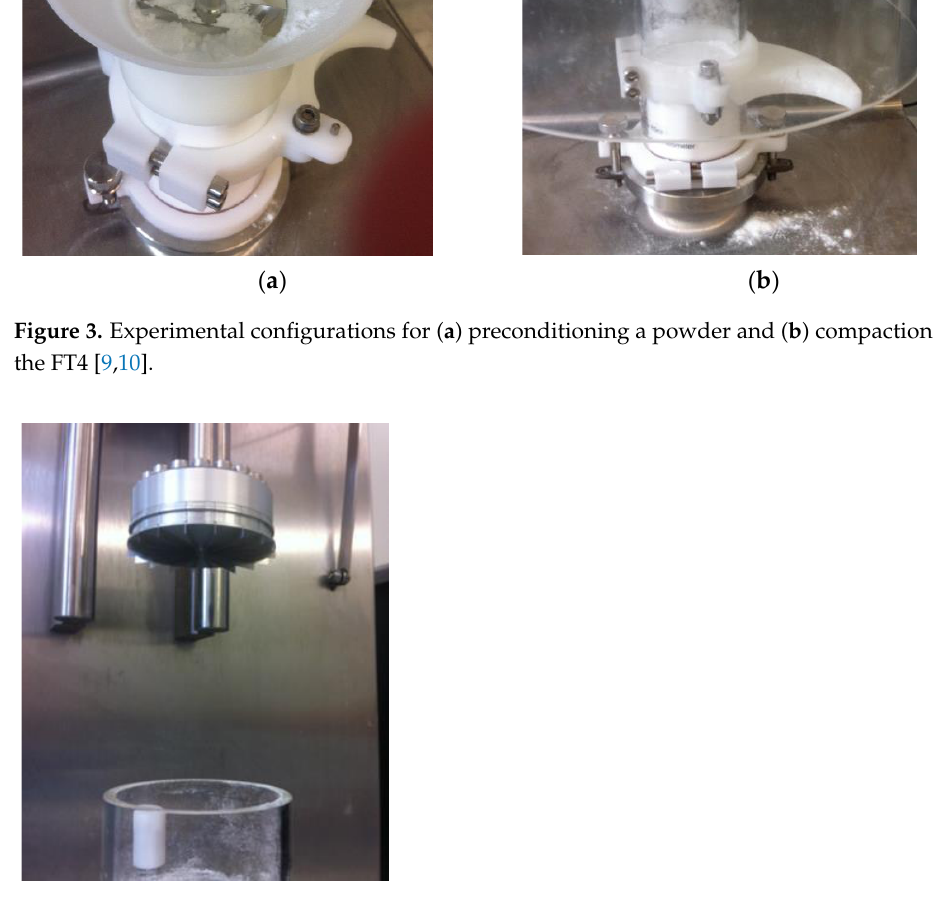
Figure 4. FT4 shear cell.